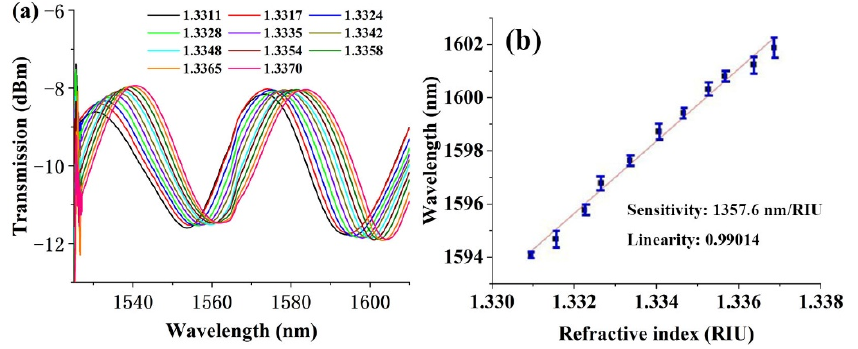
Figure 4. ( a ) Interference spectra and ( b ) responding curve as a function of refractive index for microfiber taper elaborated by silver NPs with concentration of 0.1 mol/mL.